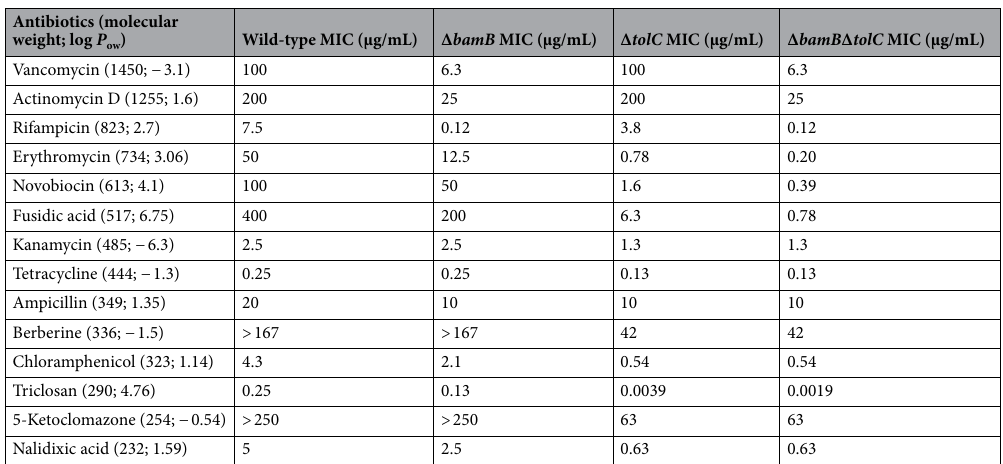
Table 1. MIC of antibiotics for deletion mutants. MIC, minimum inhibitory concentration; Δ bamB , outer membrane lipoprotein deletion mutant; Δ tolC , outer membrane efflux protein deletion mutant; Δ bamB Δ tolC , bamB and tolC double deletion mutant. Log P ow values were derived from the PubChem database (https:// pubch em. ncbi. nlm. nih. gov/) except for fusidic acid (The European Chemicals Agency, https:// echa. europa. eu/ regis trati on- dossi er/-/ regis tered- dossi er/ 20132/4/8.), berberine 18 , and 5-ketoclomazone (https:// www. hpc- stand ards. com/ msds/ 681800_ Ketoc lomaz one_ Aceto nitri le_1_ MSDS_ EN_ HPC- Stand ards. pdf).